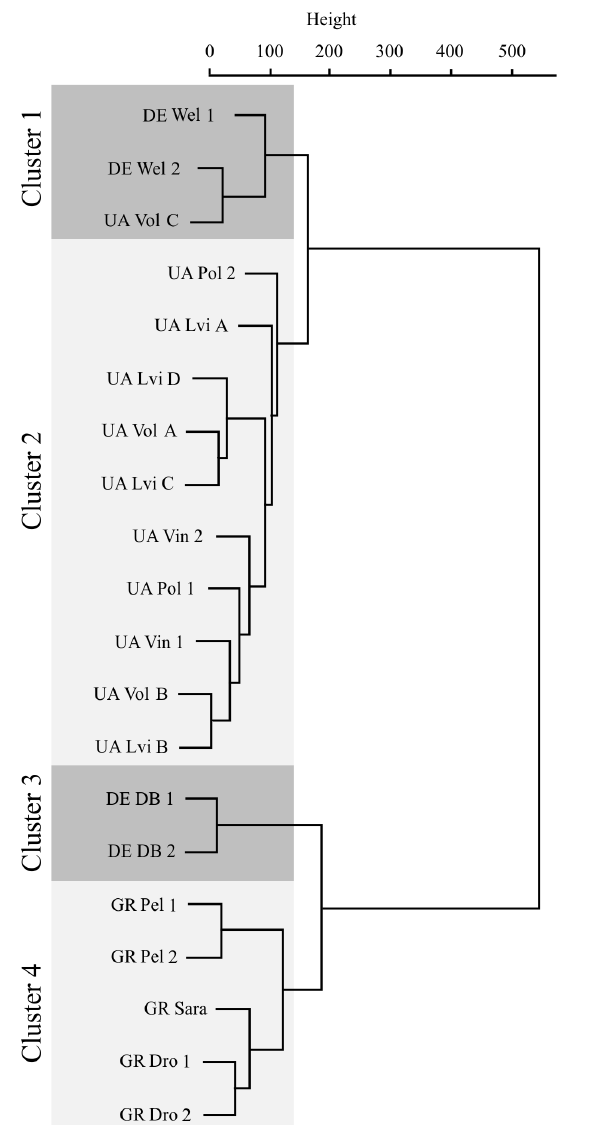
Figure 6. Investigated marginal case study sites grouped into four clusters based on influence values of their SQR hazard